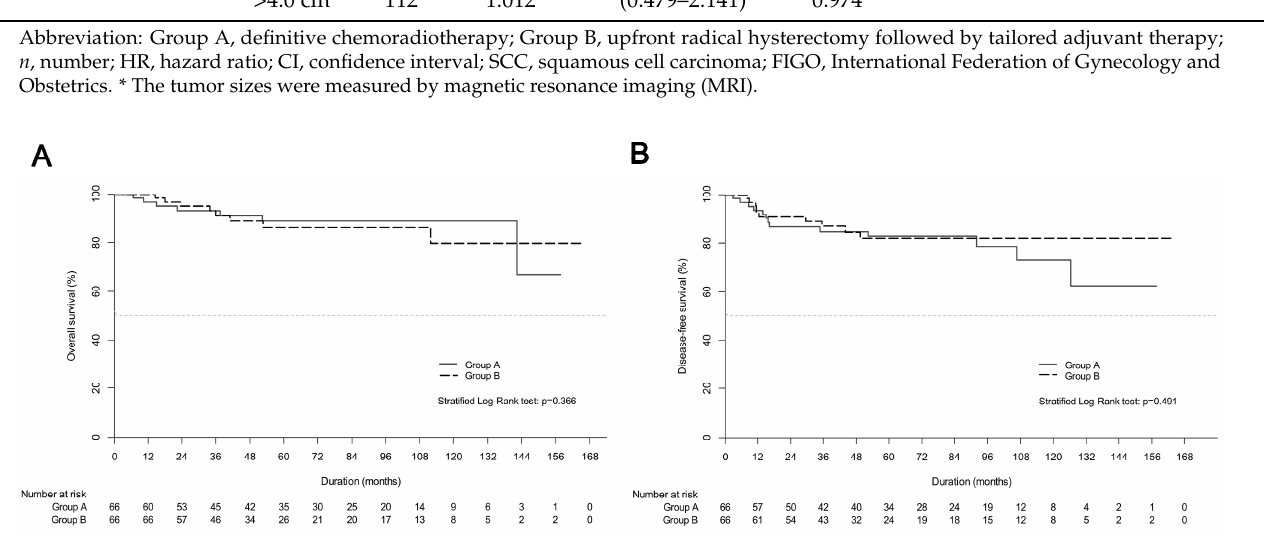
Figure 1. Kaplan-Meier estimates of ( A ) overall survival curves and ( B ) disease-free survival curves between definitive chemoradiotherapy (group A) and upfront radical hysterectomy followed by tailored adjuvant therapy (group B) in the entire cohort.